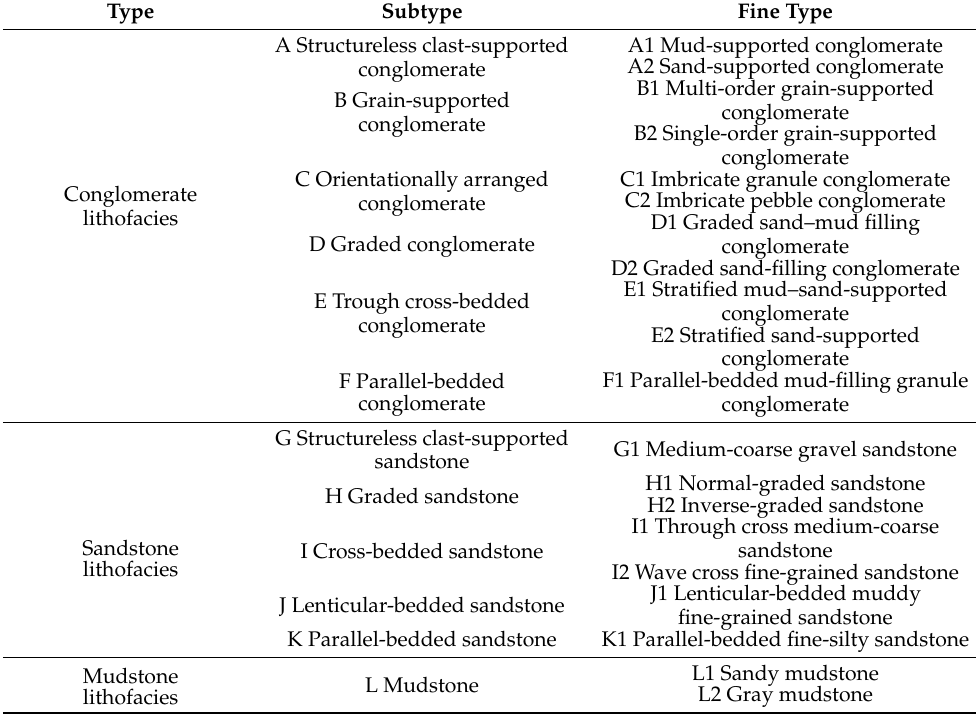
Table 1. Lithofacies types of the Lower Cretaceous Saidong